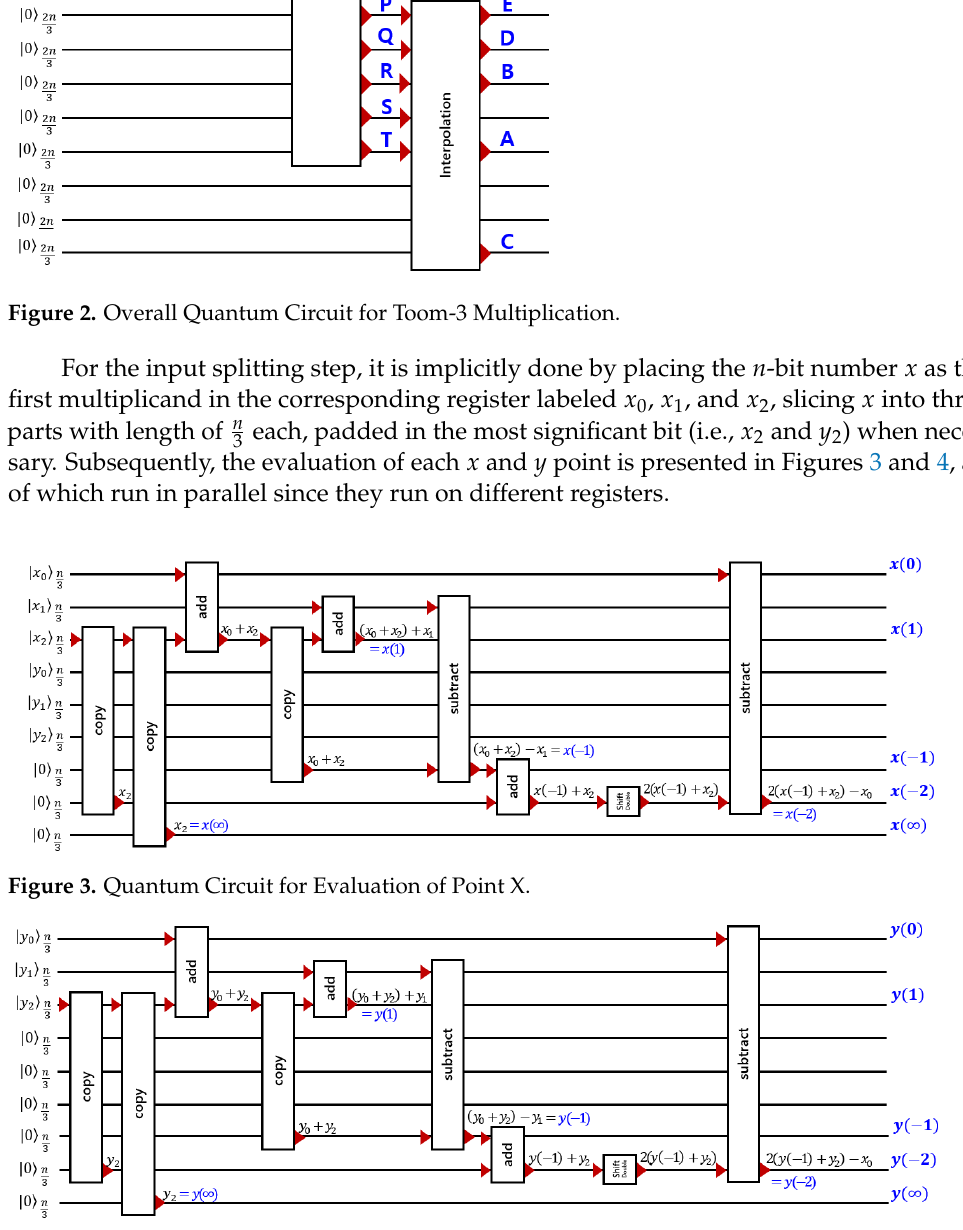
Figure 4. Quantum Circuit for Evaluation of Point